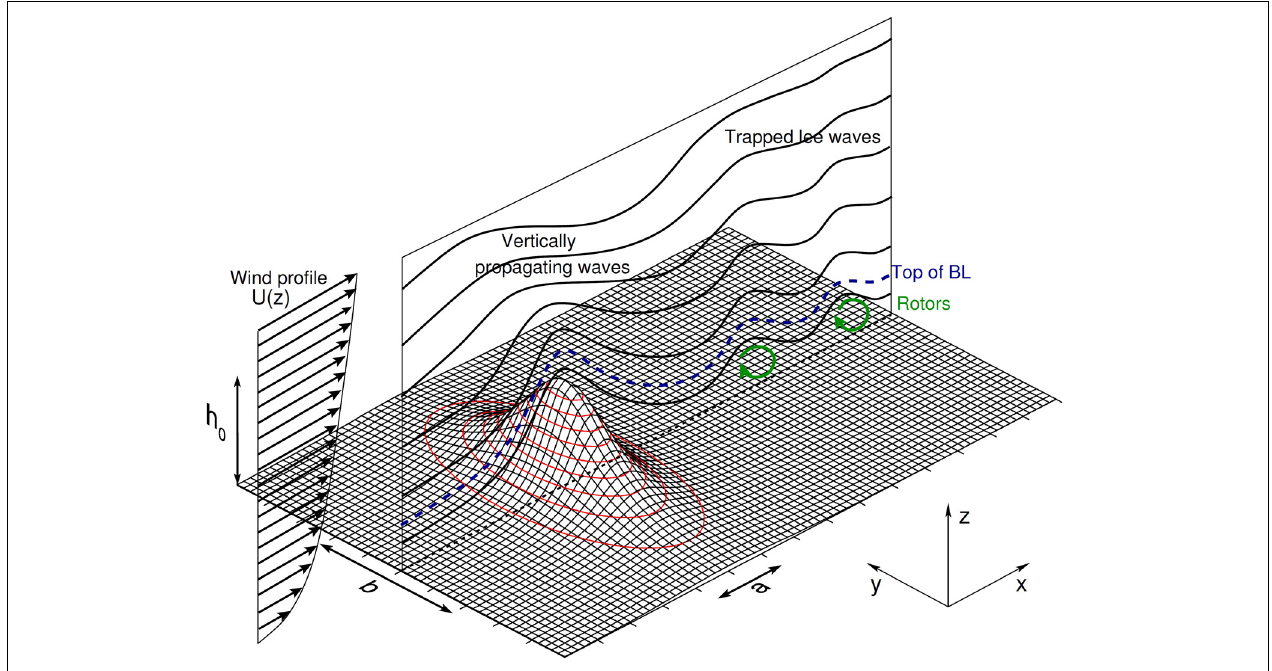
FIGURE 1 | Schematic diagram of mountain waves for a flow with ψ = 0. a and b are the mountain half-widths along x and y (for an axisymmetric mountain b = a ) and h 0 is the mountain height. Marked in the figure are flow streamlines (thick black lines), the boundary layer